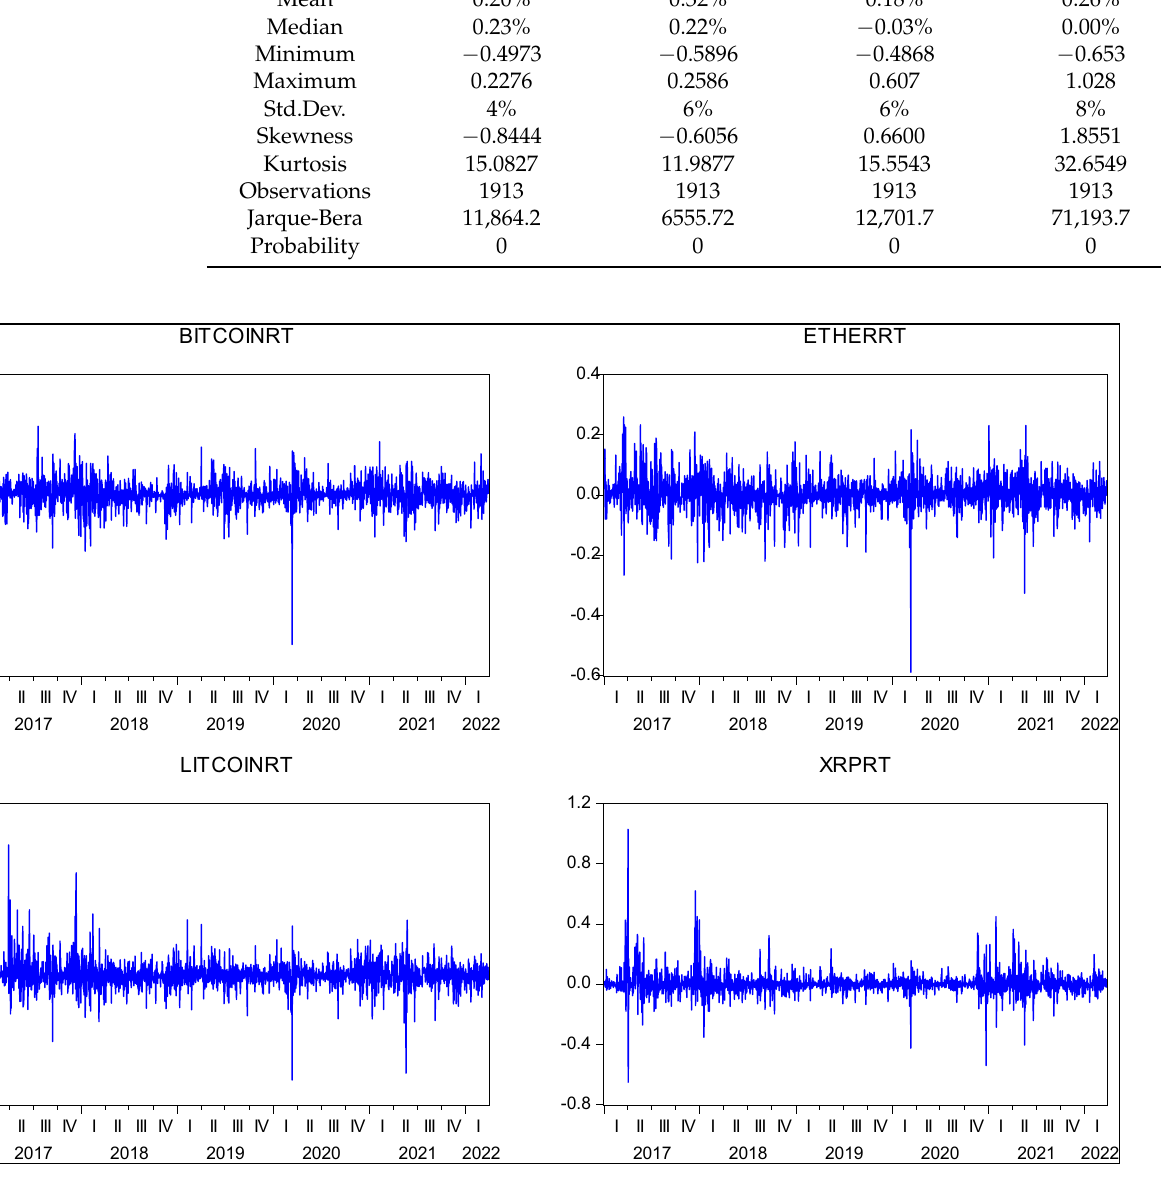
Figure 1. Daily Returns of Cryptocurrencies. Table 3. Correlation Matrix of Cryptocurrencies